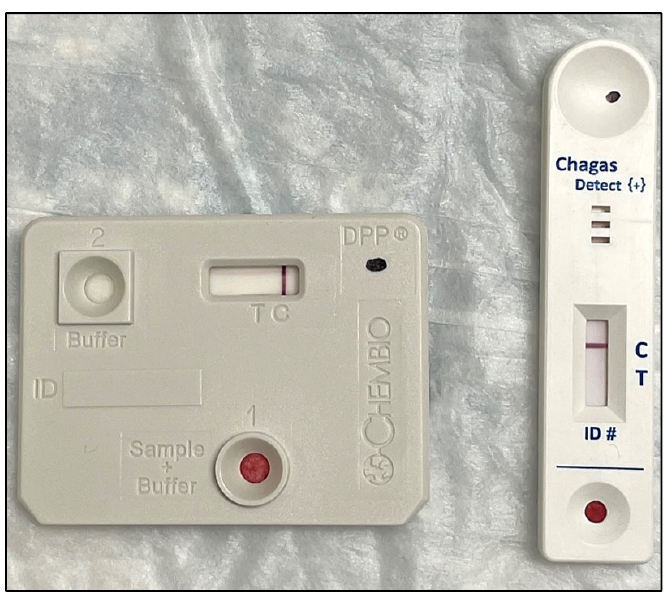
Figure 3. Rapid diagnostic tests for Chagas disease ( left —DPP ® Chagas System; right —Chagas Detect™ Plus) performed in the clinic revealed negative results (T with absent line in both tests).